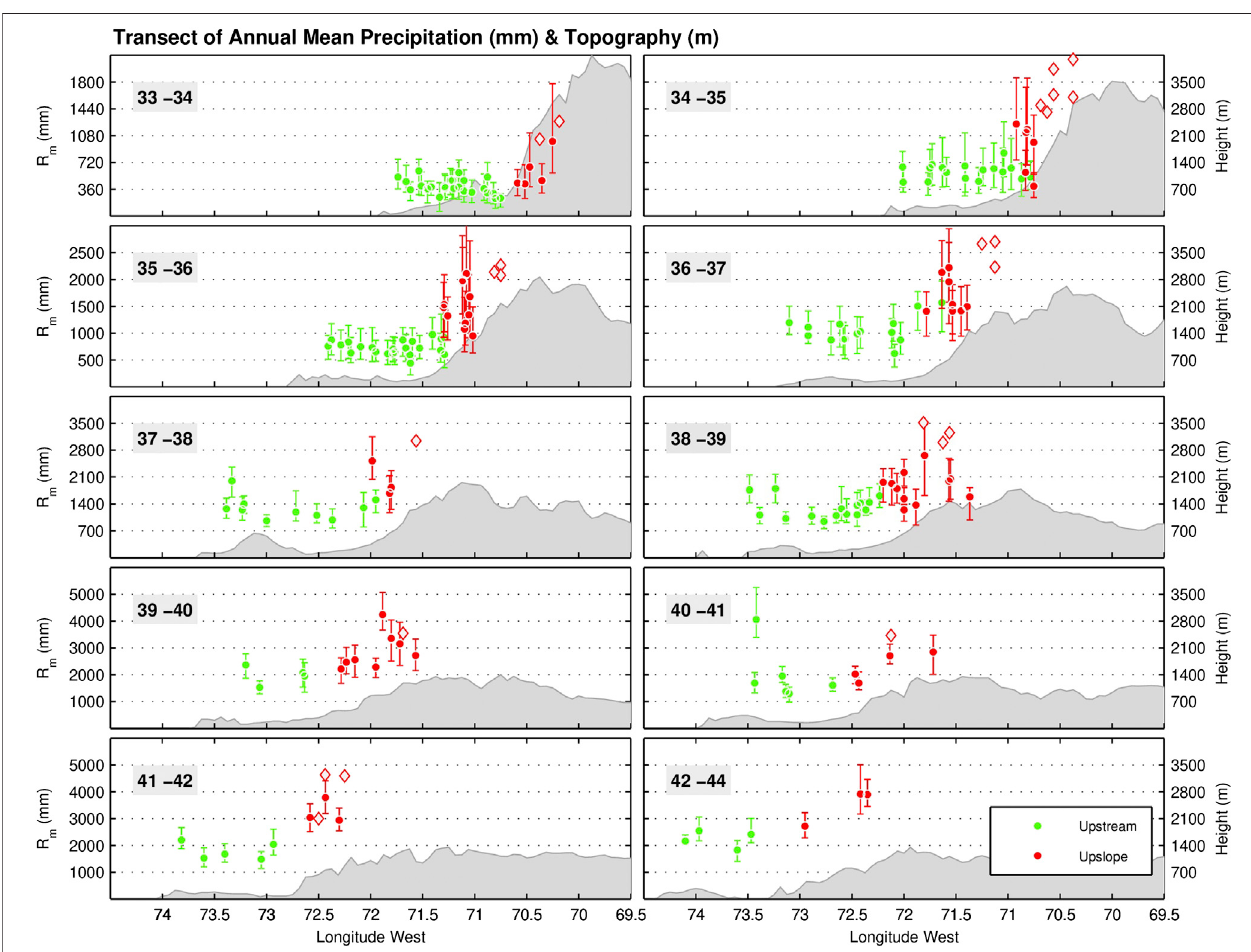
FIGURE6| Transectofannualmeanprecipitation(Rm,inmillimeters)inthesubtropicalandextratropicalAndes,fromtheupstreamtotheupslopezone(bothinthe windwardsideoftheAndes).Transects are1 ° latitude width(exceptforthe42 ° – 44 ° transectduetodataavailability) andextendfromthe 33 ° Stothe 44 ° S,where surface data were available. The circles correspond to the mean values and the bars to the minimum and maximum annual means over a 10-years period (2002 – 2011). The diamond corresponds to the mean annual precipitation estimated from river discharge gauges on upslope sector. Adapted from Viale and Garreaud (2015). © Journal Geophysical Research – Atmosphere. Reprinted by permission from John Wiley and